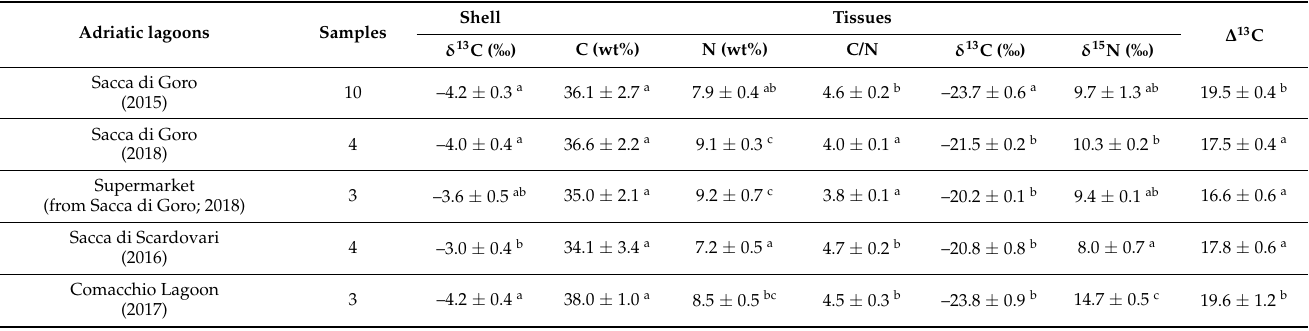
Table 1. Average elemental and isotopic compositions of carbon (C) and nitrogen (N) in the shells and tissues of manila clam samples collected onsite from north-western Adriatic lagoons and bought at the local supermarket. ∆ 13 C was calculated as the difference between the δ 13 C of shell and tissues of the clam samples. Means followed by the same letter did not differ significantly (Tukey’s HSD, p >